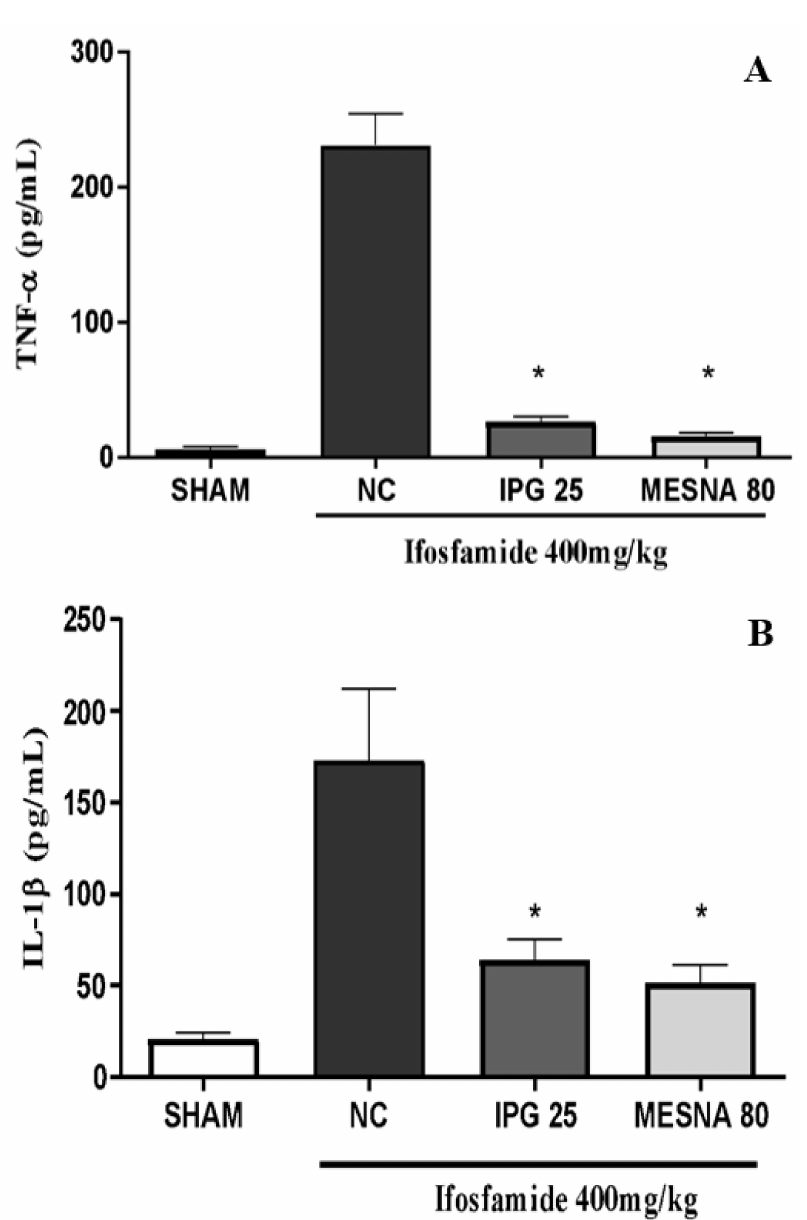
Figure 10. Effect of IPG on TNF- α ( A ) and IL-1 β ( B ) levels in the bladder tissue of animals with ifosfamide-induced hemorrhagic cystitis. Data are expressed in pg of TNF- α ( A ) or IL-1 β ( B ) per mL of bladder tissue homogenate in the mean ± SEM format ( n = 6). Data were compared with the negative control (NC, Tween/saline) by one-way analysis of variance (ANOVA), followed by the Bonferroni test; * p <